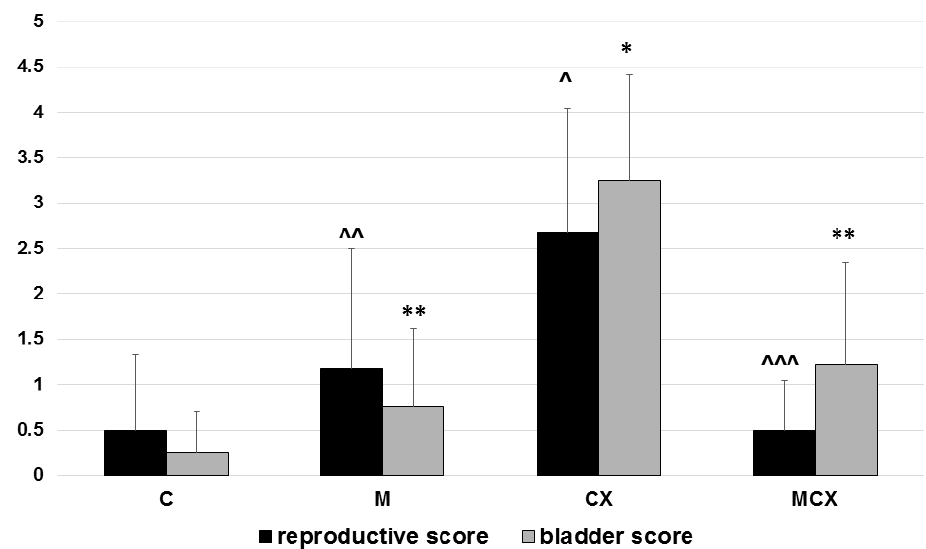
Figure 1. Total reproductive score (testes, epididymes and sperm, 0–6 points) and total urinary bladder score (hemorrhage, edema, erosions, 0–6 points). Scoring system described in the Material and Methods section. Bladder score: * p < 0.001, CX vs. C; ** p < 0.001, M vs.CX and MCX vs. CX. Reproductive score: ^ p < 0.01, CX vs. C; ^^ p < 0.05, M vs. CX and ^^^ p < 0.01, MCX vs. CX. Data presented as mean values and SD.